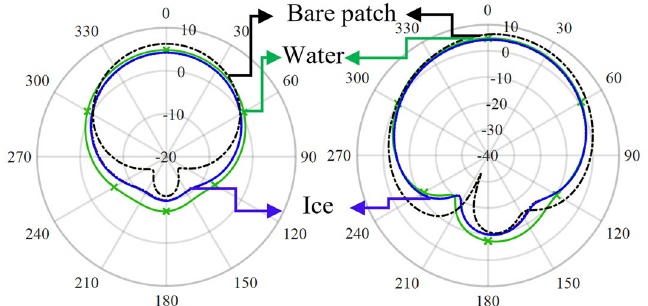
Figure 4. Antenna gain in the ( a ) H-plane and the ( b ) E-plane.